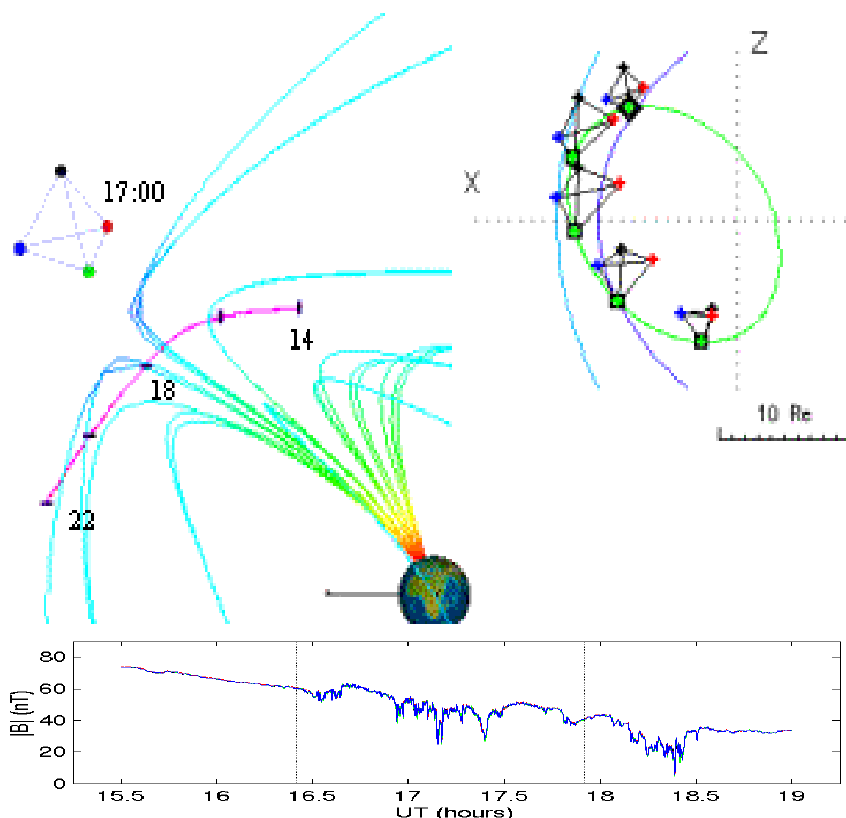
Fig. 1. Cluster orbit during 14:00–22:00 UT on 18 April 2002 projected onto the X-Z plane that contains part of a model magnetosphere at 17:00 UT obtained from the T96 model with appropriate input parameters (IMF B y =–8nT, IMF B z –8nT, Dst=-100nT, Kp=5 and solar wind pressure=1.5nPa). The cusp crossings occurred during 16:25–17:55 UT. The inset shows the orbit starting (at 18:32:23 UT) after the cusp crossing on 18 April. The satellite configuration (SC1 – black, SC2 – red, SC3 – green and SC4 – blue, expanded many times and shown for 17:00 UT) is tetrahedron during the crossing. The bottom panel shows the total magnetic field B measured by FGM on all 4 satellites during 15:30–19:00 UT; the period of the cusp crossing is marked between the vertical